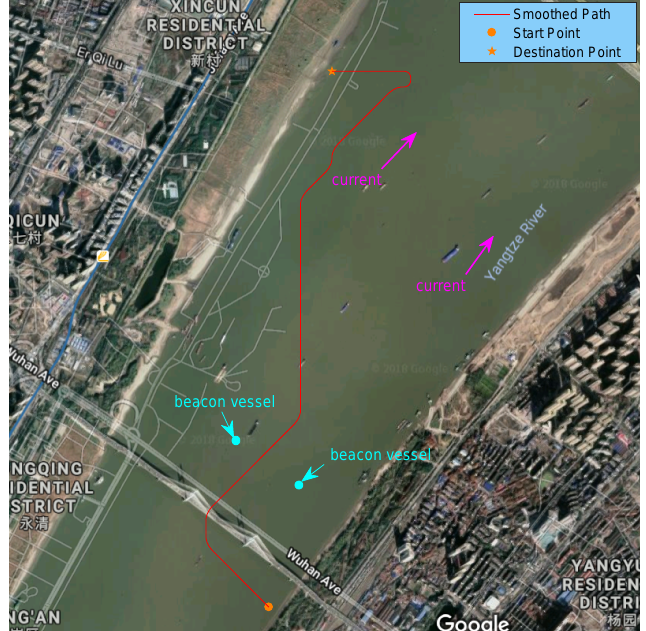
Figure 12. The smoothed path planned by the proposed A-Star algorithm in Wuhan waterway of Yangtze